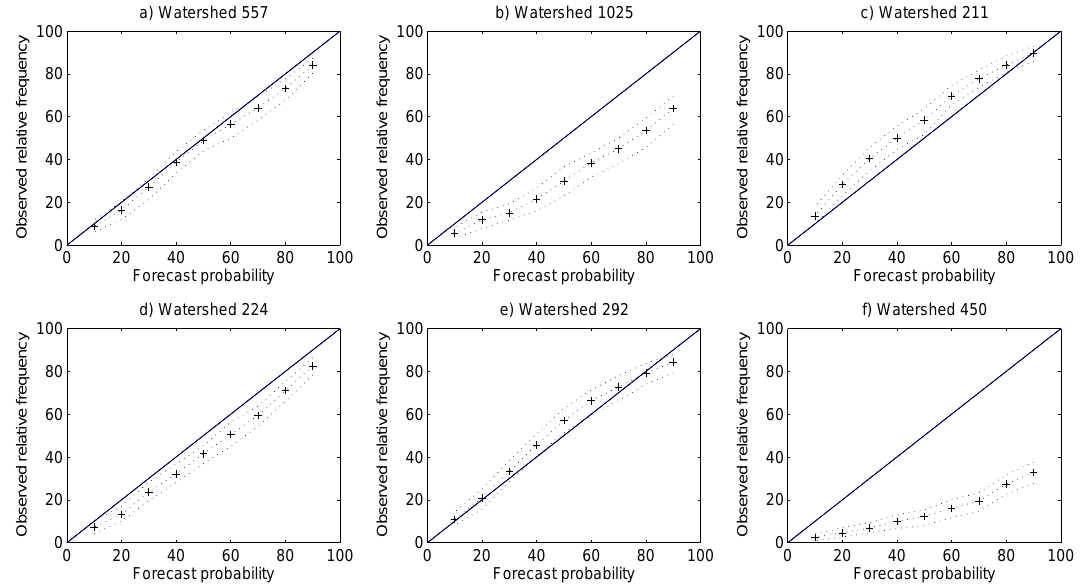
Fig. 8. Reliability plots for the same catchments as in Fig. 5, for discharge larger than quantile 75 of the observation time series. Dashed lines depict the 95% confidence interval.